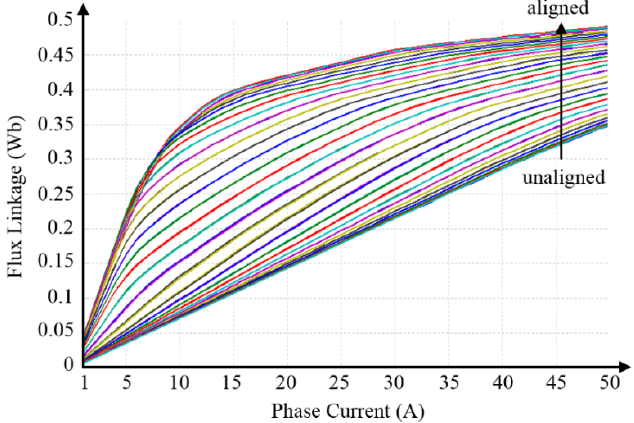
Figure 2. Magnetization characteristics of the 1 kW 8/6-pole